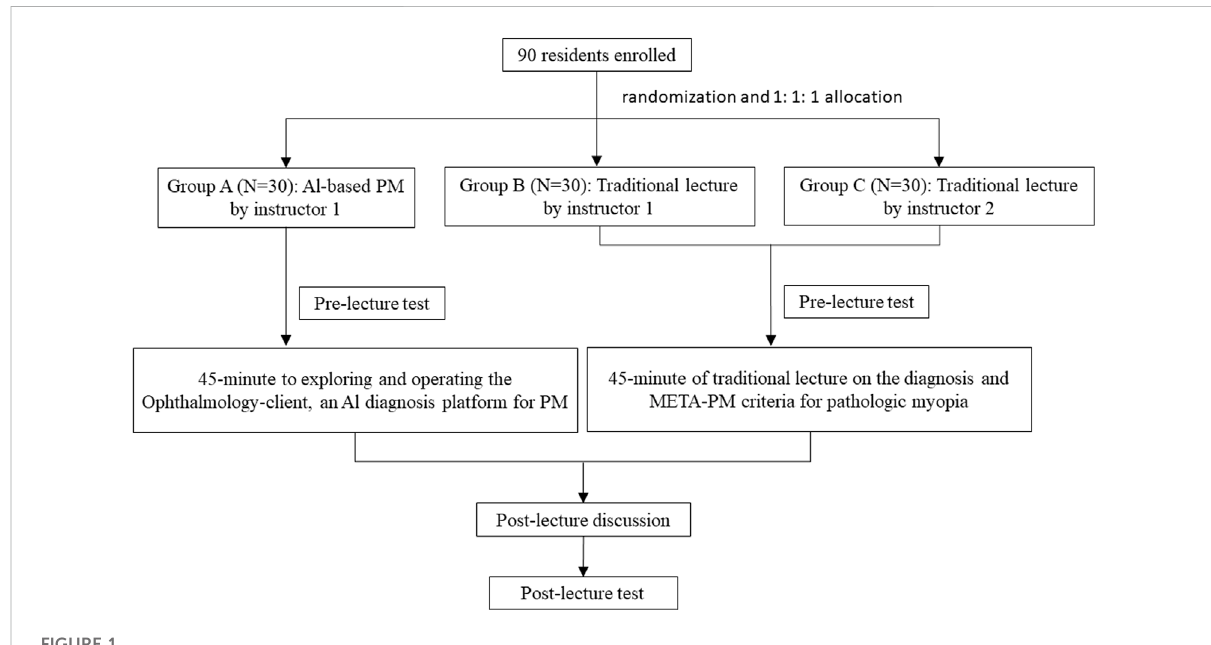
FIGURE 1 Flowchart of the